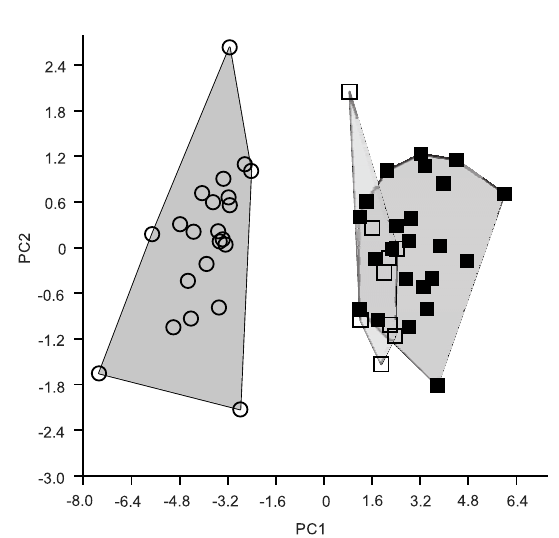
Figure 1. PCA scatter plot representing the projection of the three groups ( (cid:133) ) Myotis levis levis males, ( (cid:132) ) M. levis levis females and ( (cid:123) ) Myotis levis dinellii , in the multivariate space formed by PC1 and PC2.